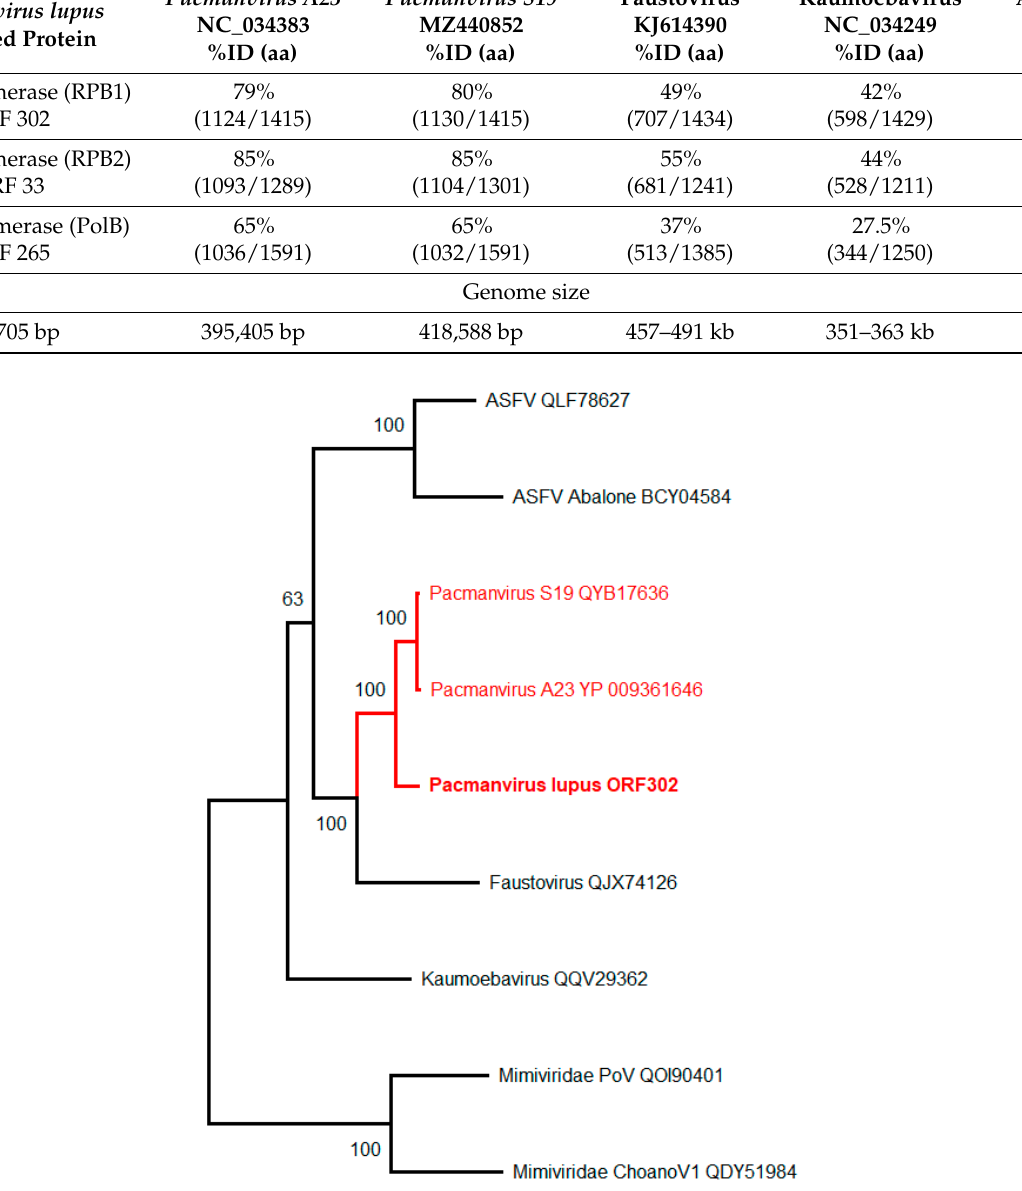
Figure 3. Maximum ‐ likelihood phylogenetic relationships of the closest Pacmanvirus lupus